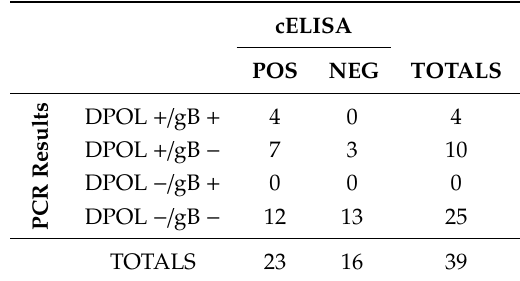
Table 2. Relation between PCR and serology results for the semi-domesticated Eurasian tundra reindeer ( Rangifer tarandus tarandus ) samples included in this study. The serology results refer to a previous survey published in 2013, where 116 out of 3339 (3.5%) apparently healthy semi-domesticated reindeer scored positive for specific antibodies to the malignant catarrhal fever virus (MCFV) group by a direct competitive inhibition enzyme-linked immunosorbent assay [28]. cELISA POS NEG